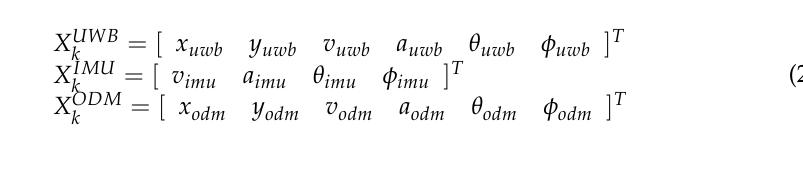
Table 2. Parameters of